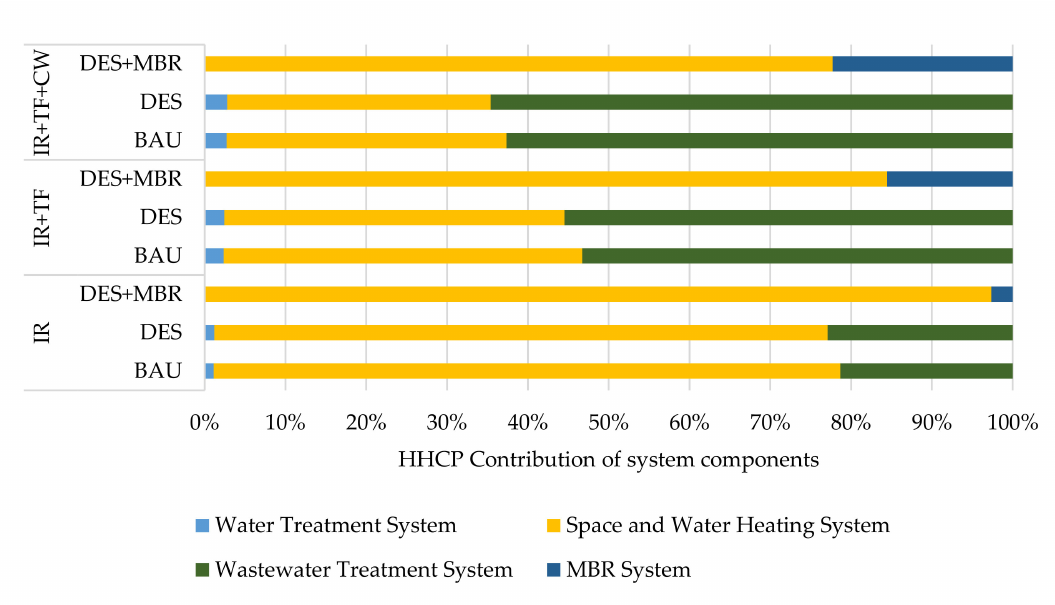
Figure 5. HHCP impact contribution of system components for the three study scenarios and water reuse options: business as usual (BAU), district energy system (DES), and district energy system with membrane bioreactor (DES + MBR); irrigation (IR), toilet flushing (TF), and clothes washing